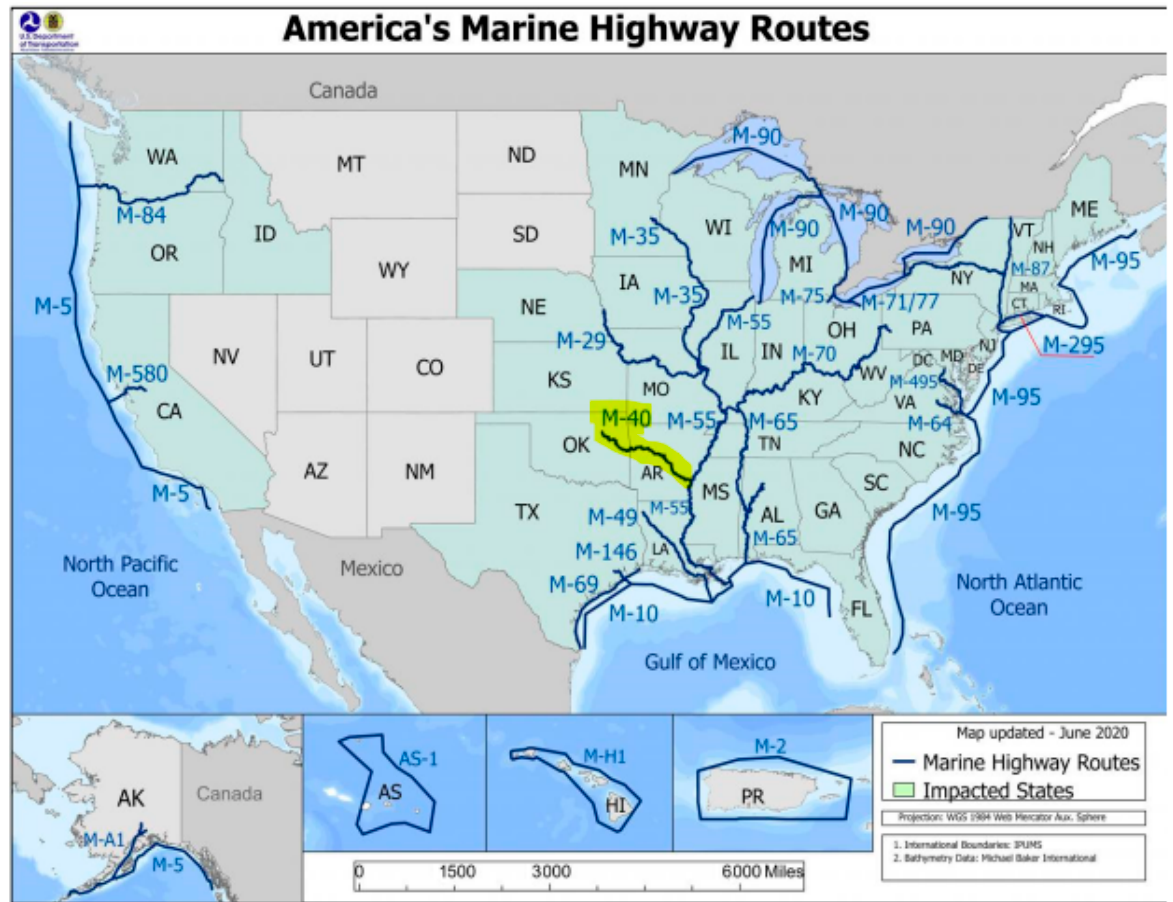
Figure 1. U.S. inland and intracoastal waterways [7].